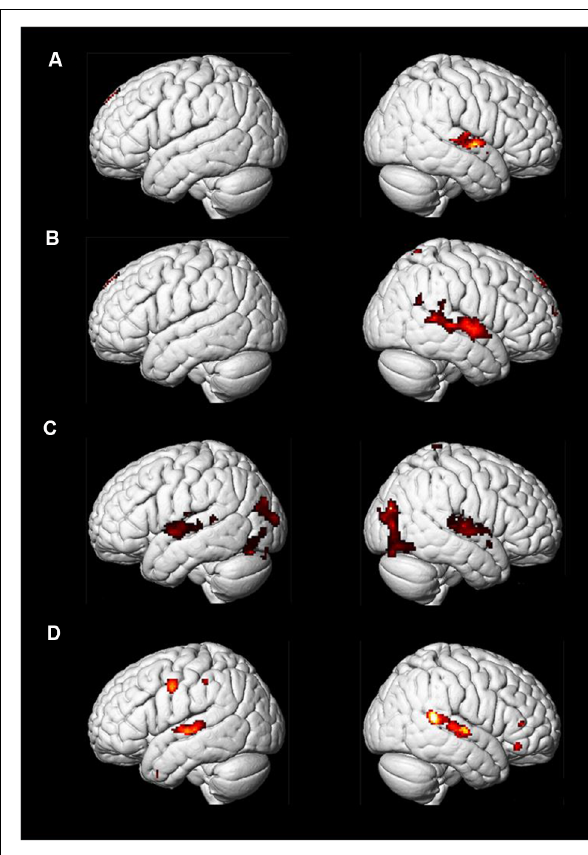
FIGURE 12 | Control participants and PP: t -maps representing areas showing activations in the Imagining and Listening a well-known melody (“Happy Birthday”): Panel (A) shows the conjunction of Imagining and Listening for the group of non-musicians. Panel (B) shows the contrast between Imagining and Listening to the same melody. Panel (C) shows brain areas active when the non-musicians listen to a piano melody while looking at the musical score sheet showing the notes. Panel (D) show the same conditions as in Panel (C) but for PP